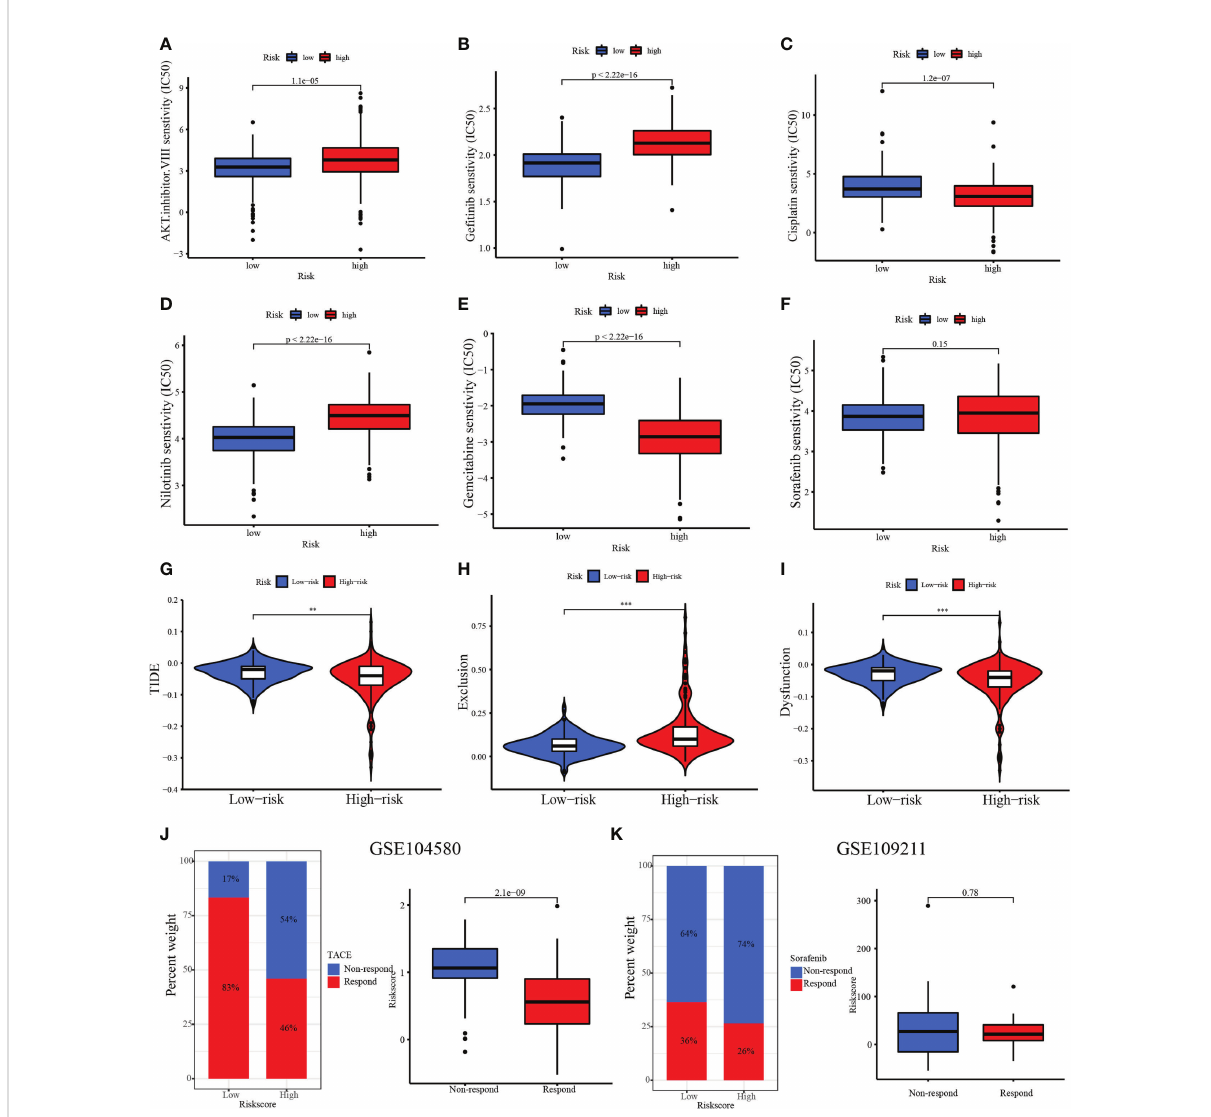
FIGURE 11 Therapeutic bene fi t of risk score. (A – F) Correlation between the MARCH ligase signature and IC 50 values of chemotherapy and targeted drugs, including (A) AKT inhibitor VIII, (B) ge fi tinib, (C) cisplatin, (D) nilotinib, (E) gemcitabine, and (F) sorafenib. (G) The relative distribution of TIDE was compared between the low- and high-risk groups. (H) The relative distribution of exclusion was compared between the low- and high-risk groups. (I) The relative distribution of dysfunction was compared between the low- and high-risk groups. (J) The distribution of the transarterial chemoembolization (TACE)-responsive group versus the TACE-non-responsive group in the low- and high-risk groups and the relative distribution of risk score in the TACE-responsive group versus the TACE-non-responsive group. (K) The distribution of the TACE-responsive group versus the sorafenib-non-responsive group in the low- and high-risk groups and the relative distribution of risk score in the sorafenib- responsive group versus the sorafenib-non-responsive group. ** p < 0.01; *** p <